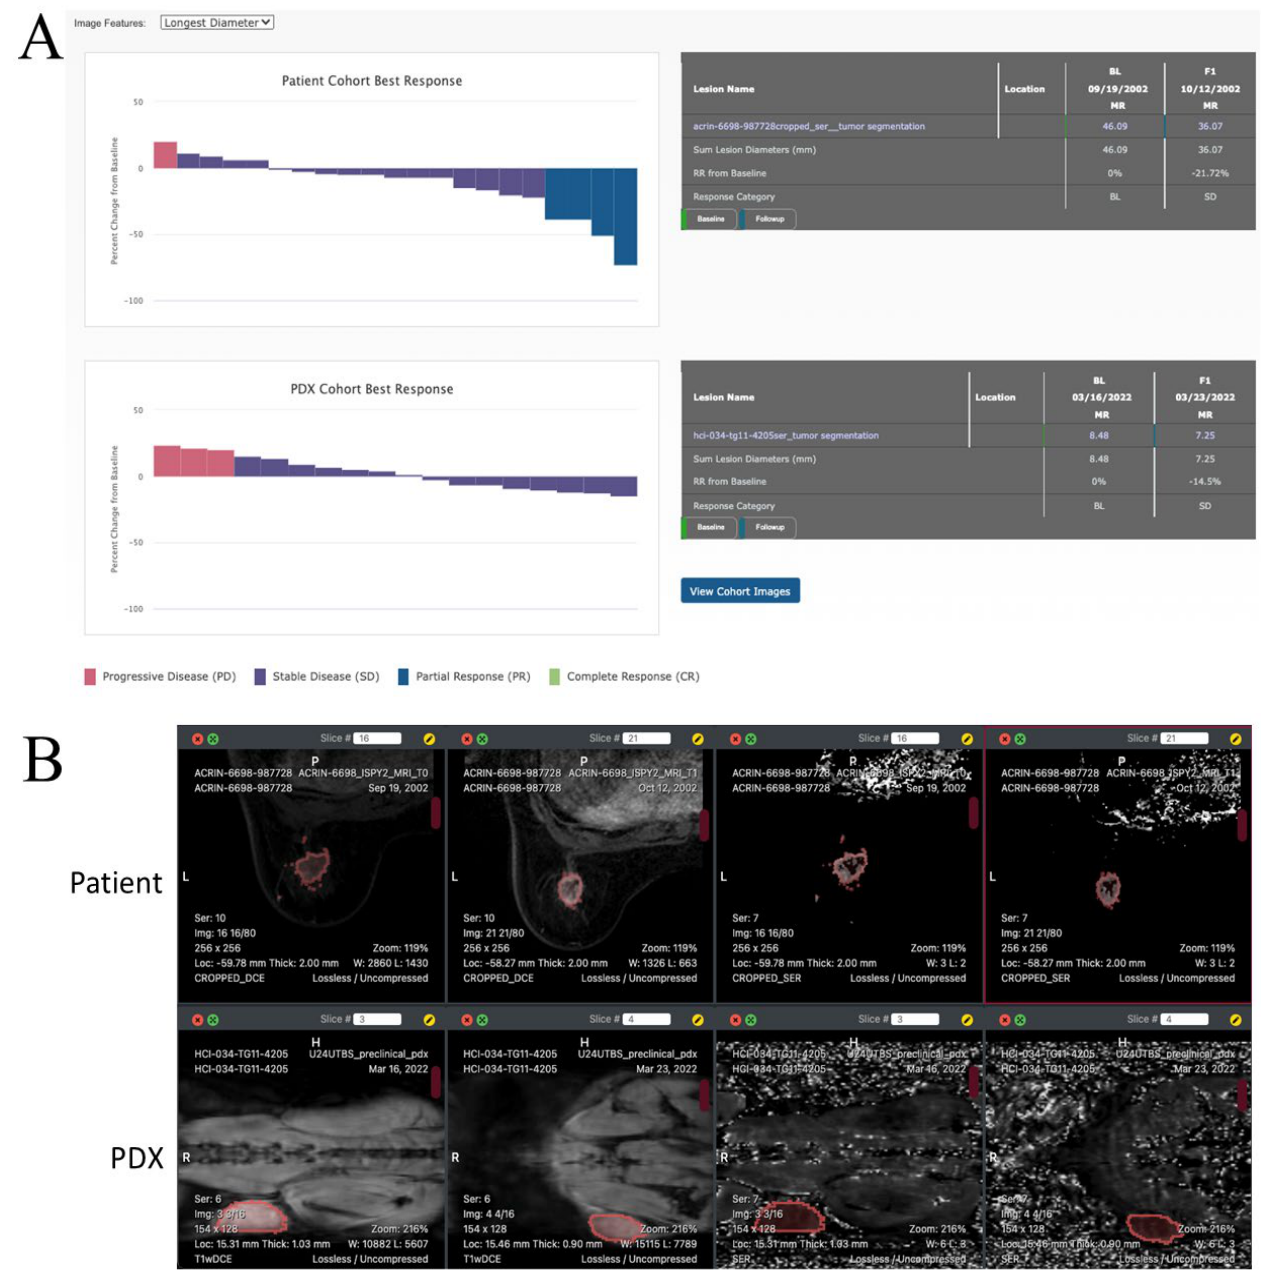
Figure 5. ( A ) Waterfall plot in MIRACCL of a treatment response in a cohort of patients (left) and in the corresponding cohort of PDX animals (right) based on the longest diameter of cancer lesions in pre-treatment and on-treatment images. These plots are generated by ePAD and displayed by MIRACCL. ( B ) Patient (top row) and corresponding PDX (bottom row) images as displayed in MIRACCL (tumor outlined in red). From left to right in the top row: T1W pre-treatment, T1W on-treatment, SER pre-treatment, and SER on-treatment for a patient from the I-SPY2 cohort. The bottom row shows four images of a biosimilar PDX model. From left to right: T1W pre-treatment, T1W on-treatment, SER pre-treatment, and SER on-treatment.